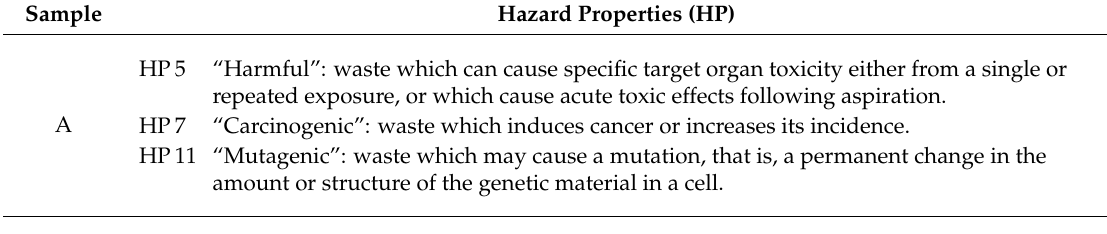
Table 1. The waste characterization.